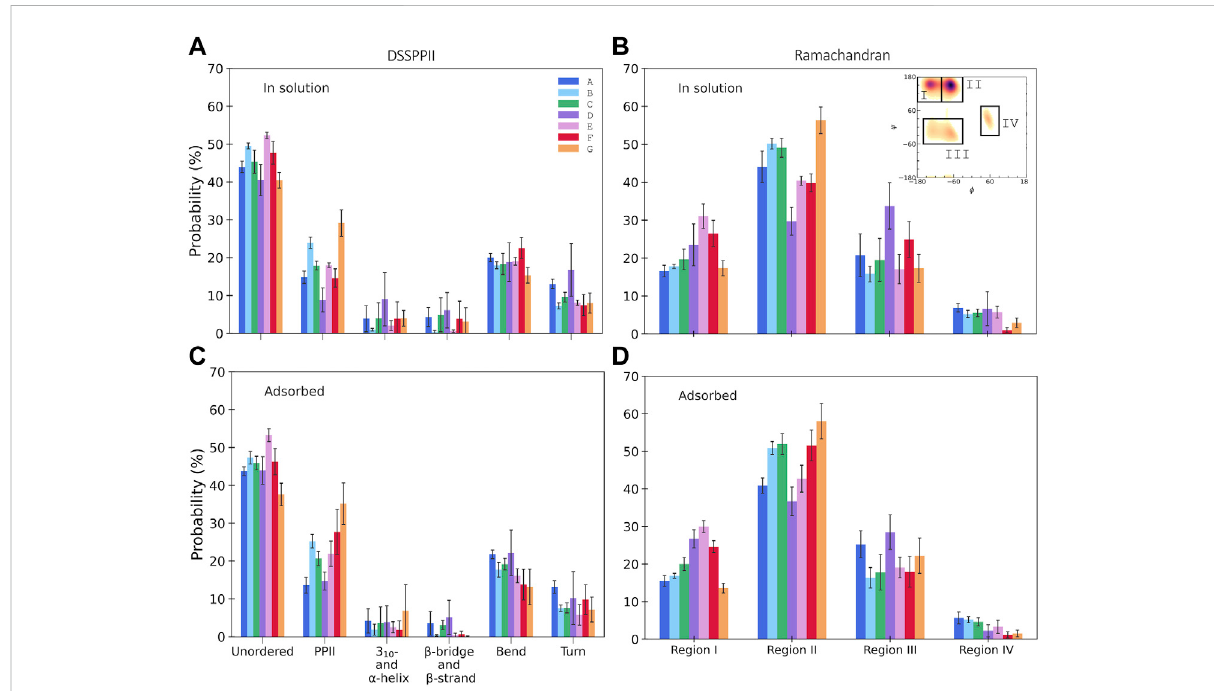
Secondary structure content from integrated Ramachandran plots, in the regions as indicated in the inset (see the Supplementary Material for speci fi edangles),forKEIFinsolution (A) andadsorbed (B) ,andDSSPPIIanalysisforKEIFinsolution (C) andadsorbed (D) .Structuresknowntooccurin theRamachandranregionsareI) β -strands,II)PPIIhelices,III)3 10 -andright-handed α -helices,andIV)left-handed α -helices.Errorbarsrepresentthe standard deviation between